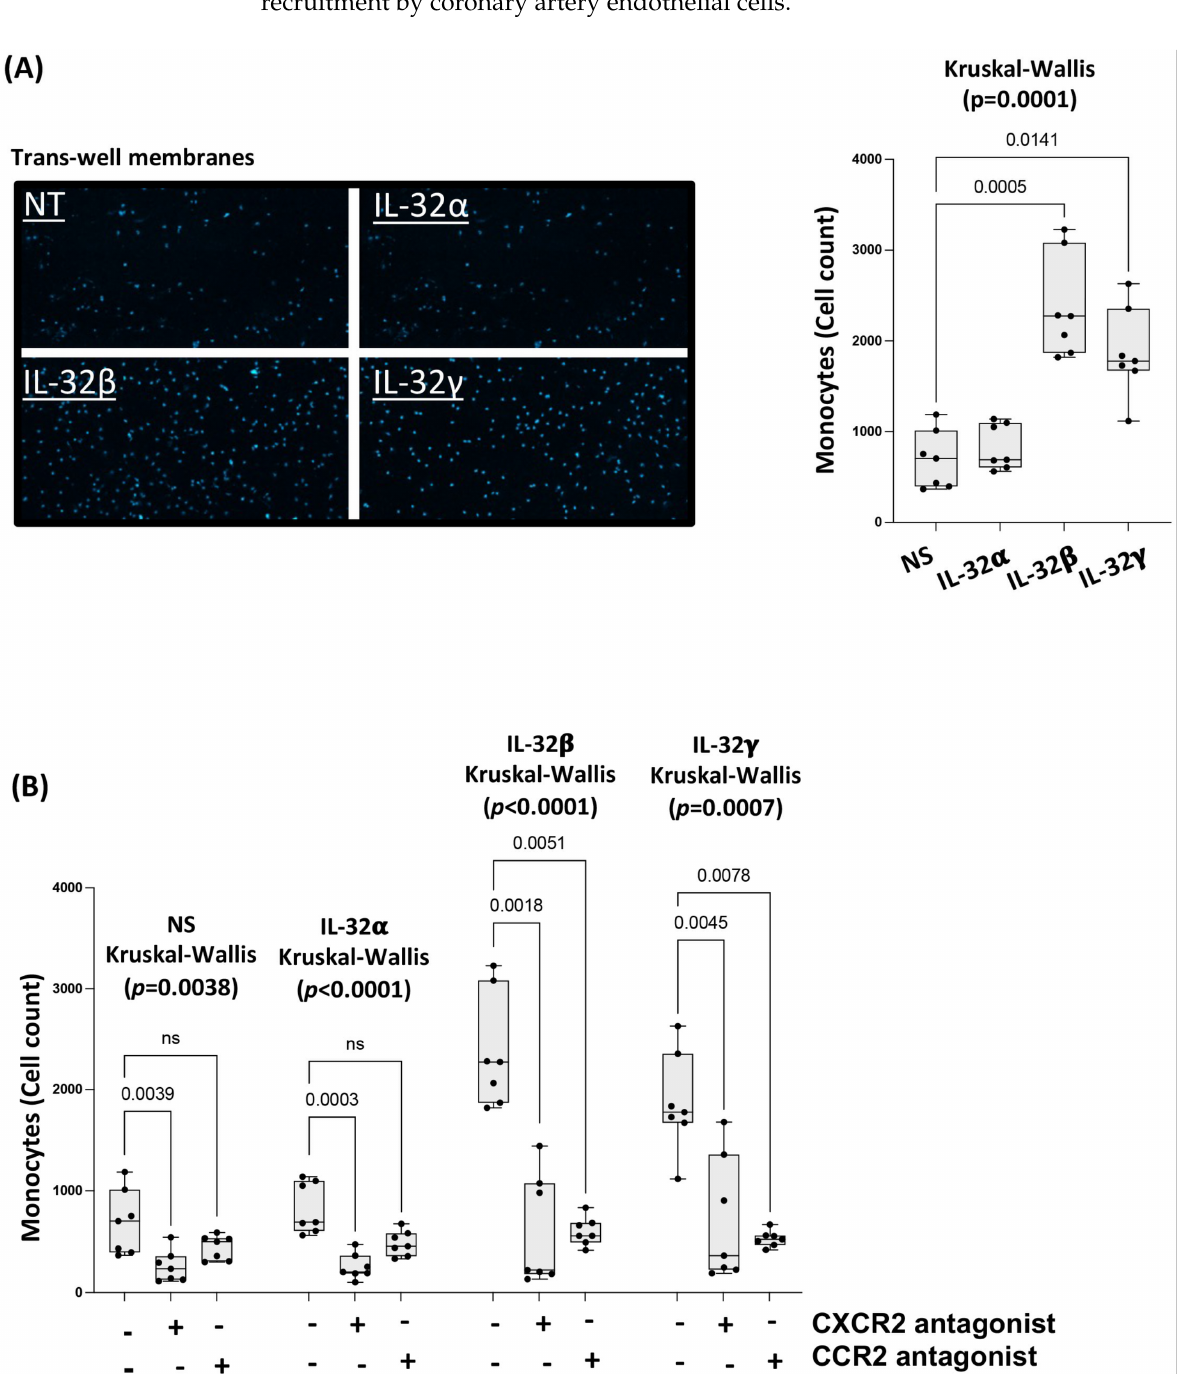
Figure 4. IL-32 β - and γ -induced chemokines drive monocyte transmigration toward CAEC super- natants. ( A ) Left panels: Representative fluorescent microscope images for monocytes attached to the lower side (surface facing the lower chambers) of the transwell membrane. Nuclei stained with DAPI on the transwell membranes. Right panel: Analysis for the numbers of migrated cells towards the CAEC supernatant stimulated with IL-32 α , β and γ (n = 7). ( B ) Analysis for the impact of pre-treating monocytes with the antagonists of either CCR2 or CXCR2 prior to exposure to supernatants from CAEC non-stimulated or stimulated with the IL-32 α , β and γ isoforms (n = 7). Dots on the graphs represent experimental replicates from CAEC. NS: non-stimulated. ns: